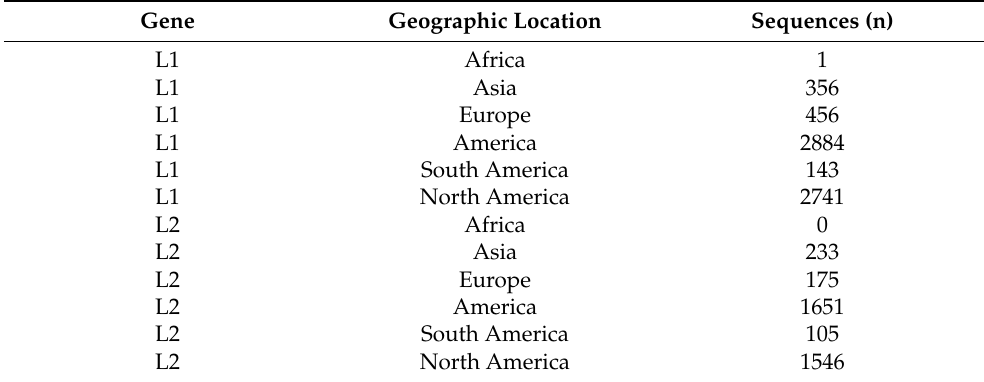
Table 1. Sequences retrieved from the different geographic regions. Gene Geographic Location Sequences (n)